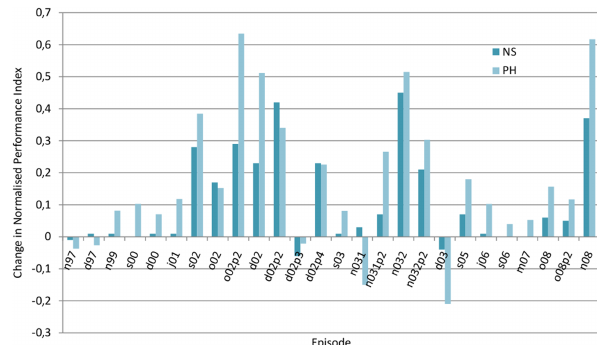
Fig. 11. Improvements in simulation quality indicators for the 19 rainfall episodes. The dark blue bars represent NS α − NS MFB . The light blue bars are the difference in the normalised peak flow crite- ria, PH MFB − PH α